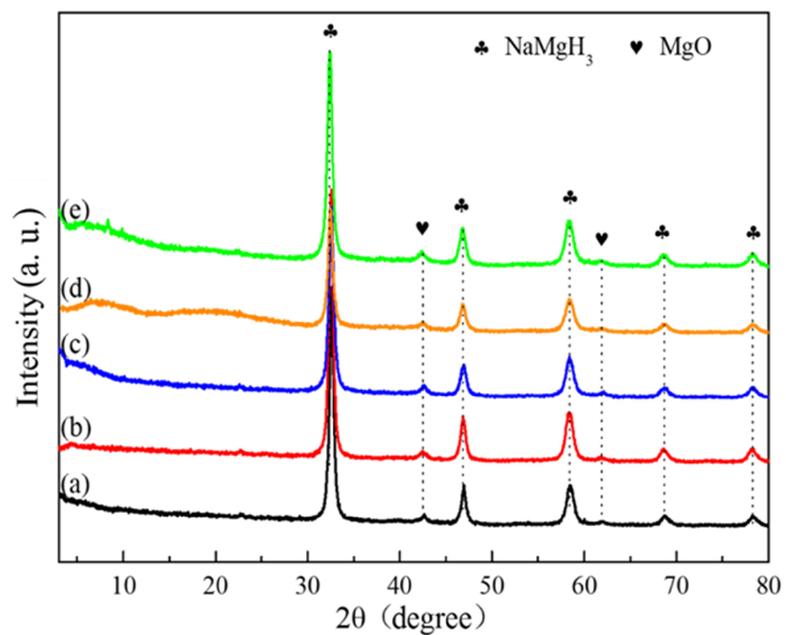
Figure 2. XRD patterns of ( a ) pure NaMgH 3 , ( b ) NaMgH 3 -3 wt.% Ti 3 C 2 , ( c ) NaMgH 3 -5 wt.% Ti 3 C 2 , ( d ) NaMgH 3 -7 wt.% Ti 3 C 2 , and ( e ) NaMgH 3 -9 wt.% Ti 3 C 2 . After assessing the phase components and morphology of NaMgH 3 -x wt.% Ti 3 C